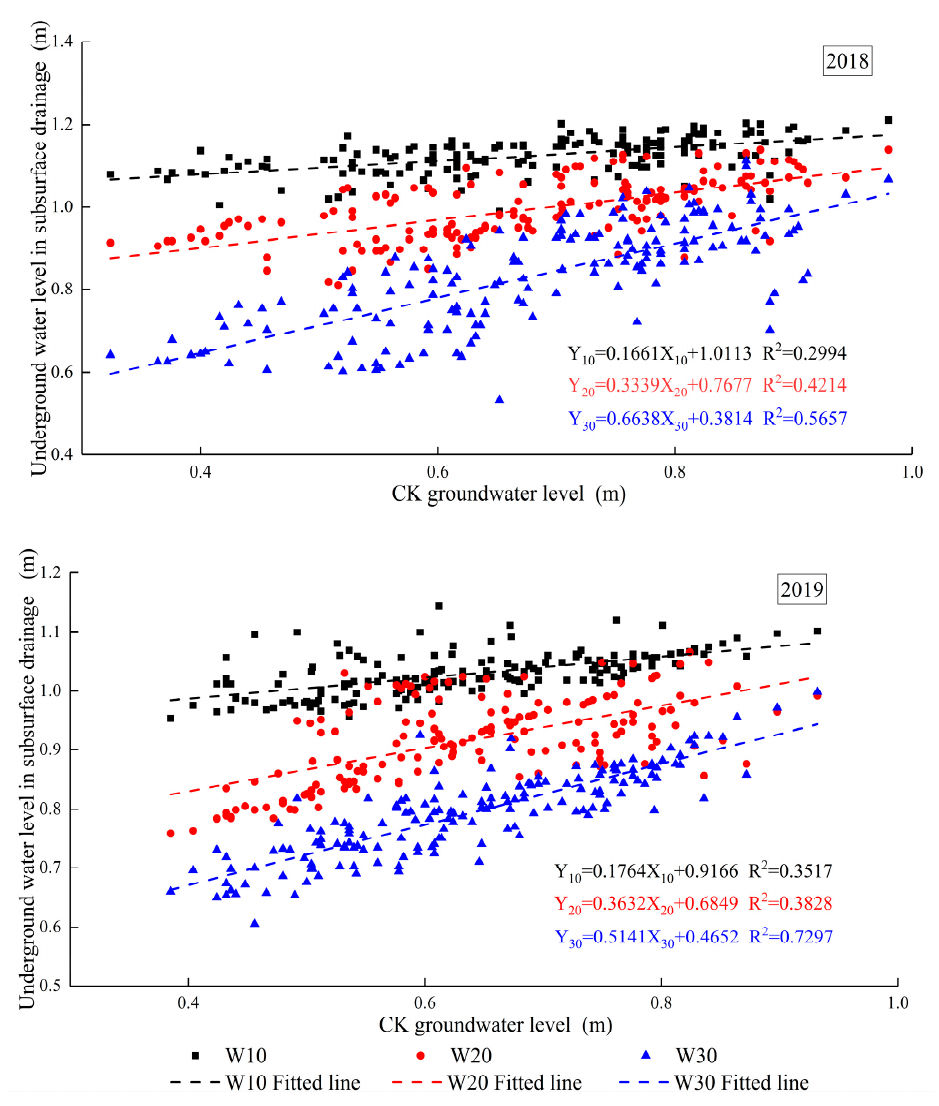
Figure 8. Response relationship between groundwater tables of subsurface drainage and groundwater table of CK. W10, W20, and W30 mean the drain spacing of 10, 20, and 30 m, respectively. CK means no drainage.